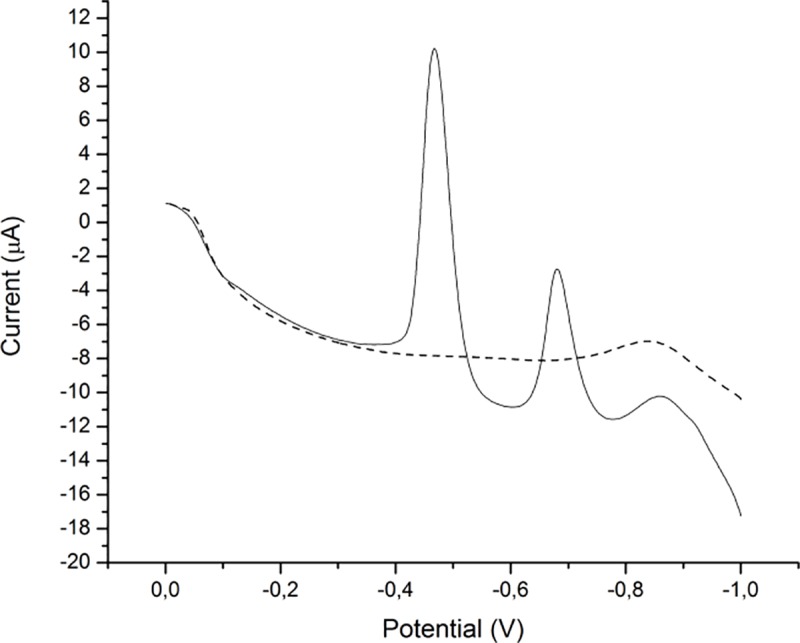
Voltammograms of river sample (dashed) and river sample spiked with 0.5 μmol/dm3Pb(II) and Cd(II) (solid).